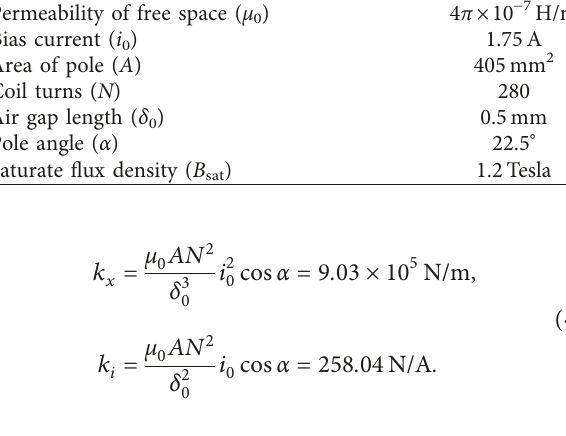
Figure 1: Model of an eight-pole radial magnetic bearing. Table 1: Structural parameters of radial AMB. Parameter